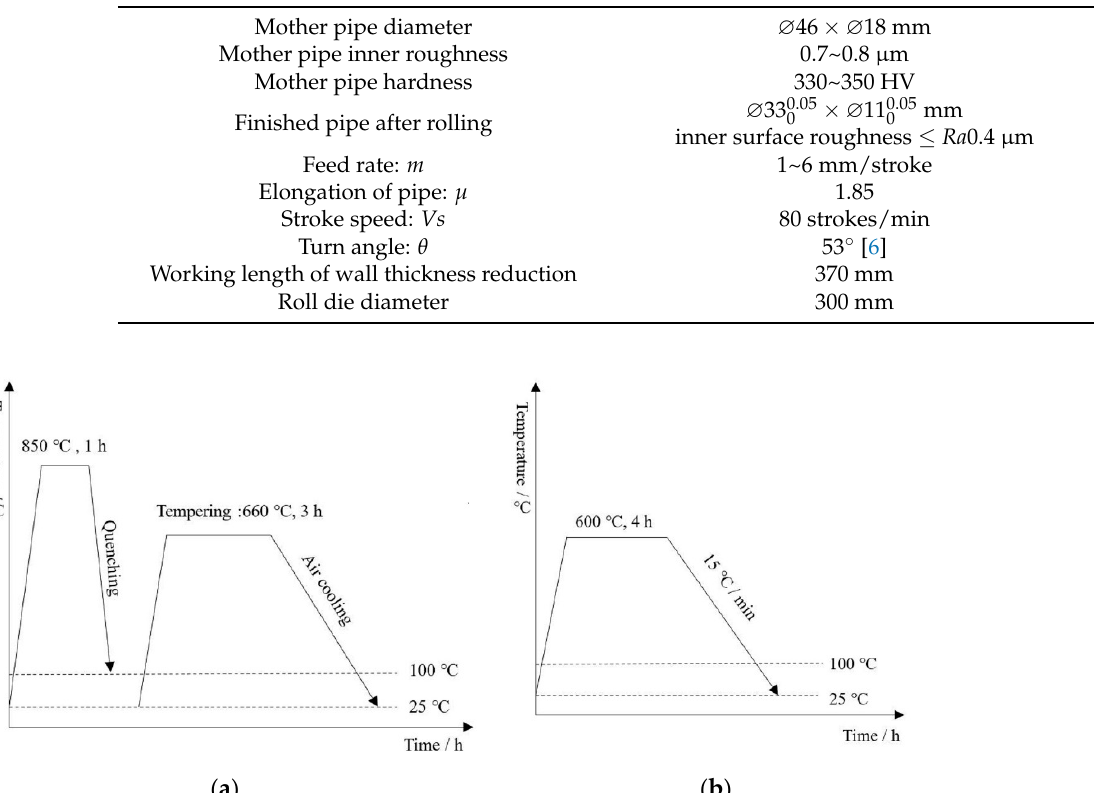
Table 2. The parameters of the rolling experiment.